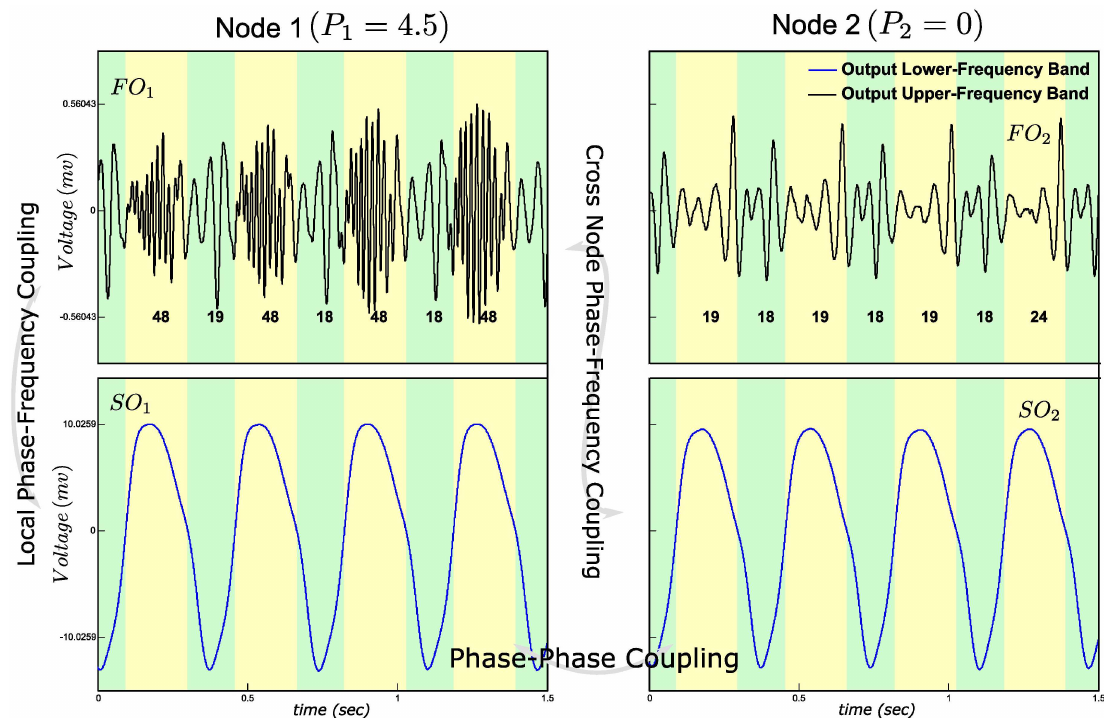
Fig 2. Phase-Frequency Coupling (PFC) simulation. Time domain signalsare shown for visual inspectionof each CFC. FO 1 , SO 1 , FO 2 and SO 2 are the filtered output of the Node 1 and Node 2 respectively. The frequency of FO 1 varies betweenpositive (yellowstripes) and negative (green stripes) phases of SO 1 . SO 1 and SO 2 are synchronized(i.e., cross-node PPC). Integers belowthe FO time waves are averagenumbers of FO zero crossings, which is used as an index of averagefrequency of each phase. Local PFC betweenFO 1 and SO 1 and cross-node PFC betweenFO 1 and SO 2 are